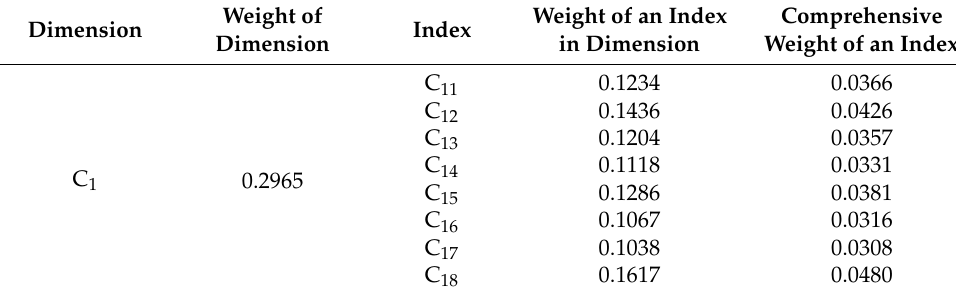
Table 6. SIP intelligence level evaluation index